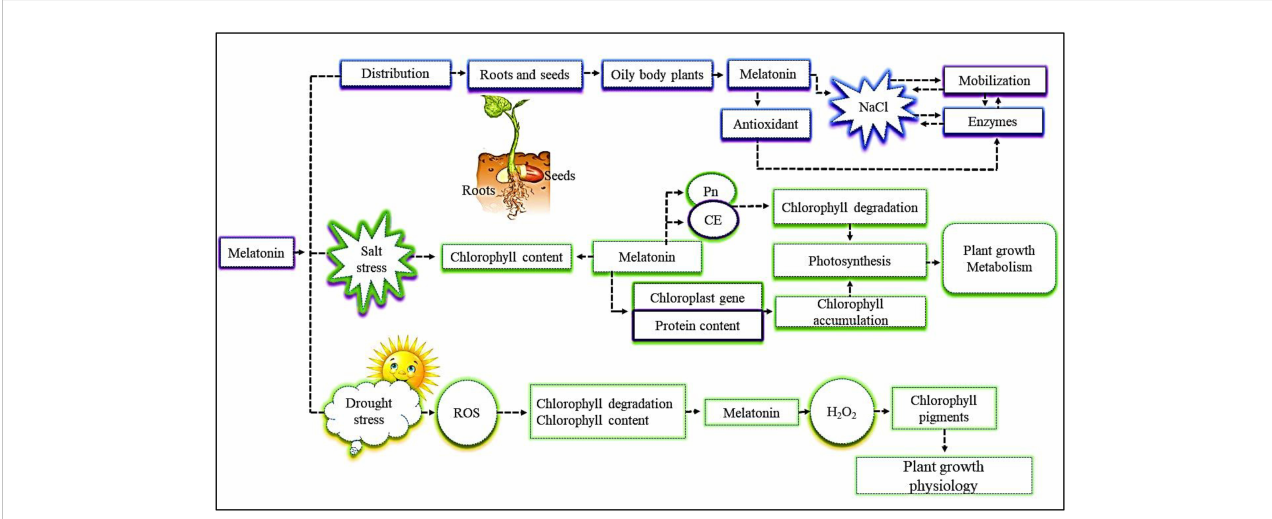
FIGURE 2 The distribution and regulatory roles of an exogenous supply of melatonin in mitigating abiotic stresses are divided into three parts. (i) Melatonin distributed in the roots and seeds. Sodium chloride (NaCl) induces slow mobilization of enzymes and reduces the enzymes ’ activity in the oily body of plants in seedlings and roots and, as a result, alters salt stress. The supply of exogenous melatonin enhances the level of plant antioxidants and enzyme activities. (ii) Salt stress reduces chlorophyll content, but exogenous melatonin improves chlorophyll content, chloroplast gene expression, and protein content, and, as a result, enhances photosynthesis activity and chlorophyll accumulation. In addition, it enhances plant Pn and CE and, as a result, inhibits chlorophyll degradation. The improvement of all these traits enhances plant growth and metabolism. (iii) Drought stress causes ROS in plants, which induces Ch degradation and Ch reduction. The application of endogenous melatonin during drought reduces ROS and O 2 – content and, as a result, increases chlorophyll content and plant growth physiological function. CE , carboxylation ef fi ciency; Ch , chlorophyll; Pn , net photosynthetic rate; ROS, reactive oxygen